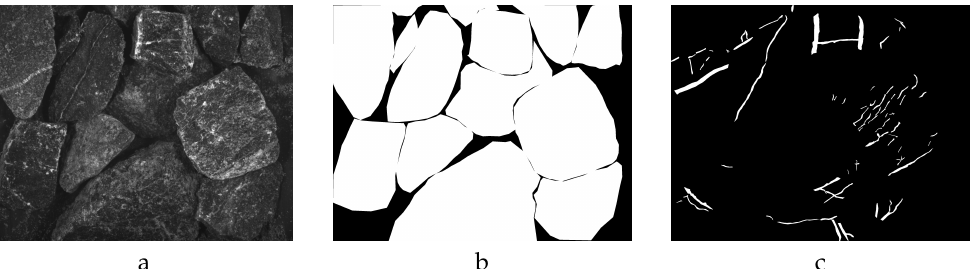
Figure 5. The typical image ( a ), its labelled mask of stone boundaries ( b ), and veins ( c ) for the dataset № 2.